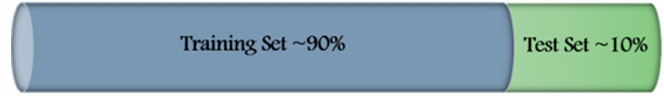
Figure 7. Train–Test split